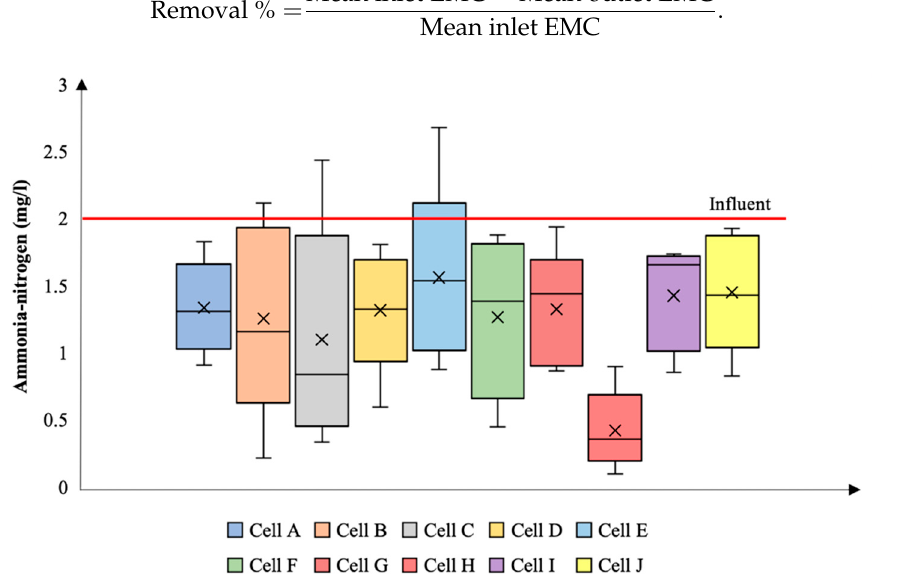
Figure 6. Concentration of ammonia-nitrogen. Sample number = 5; box plots show medians and 25th and 75th percentiles; whiskers represent the 10th and 90th percentiles.